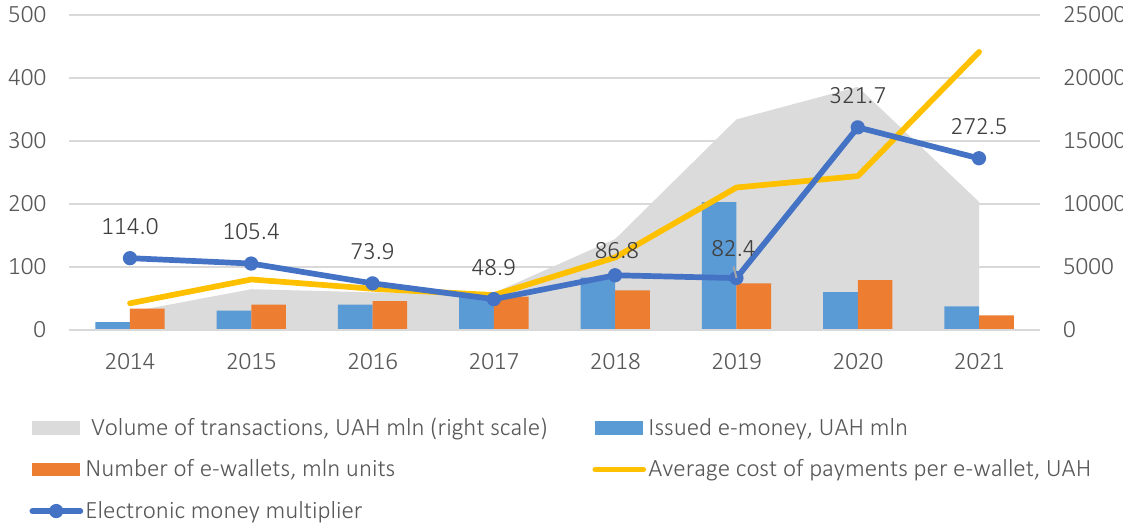
Figure 1. Issue and circulation of electronic money in Ukraine in